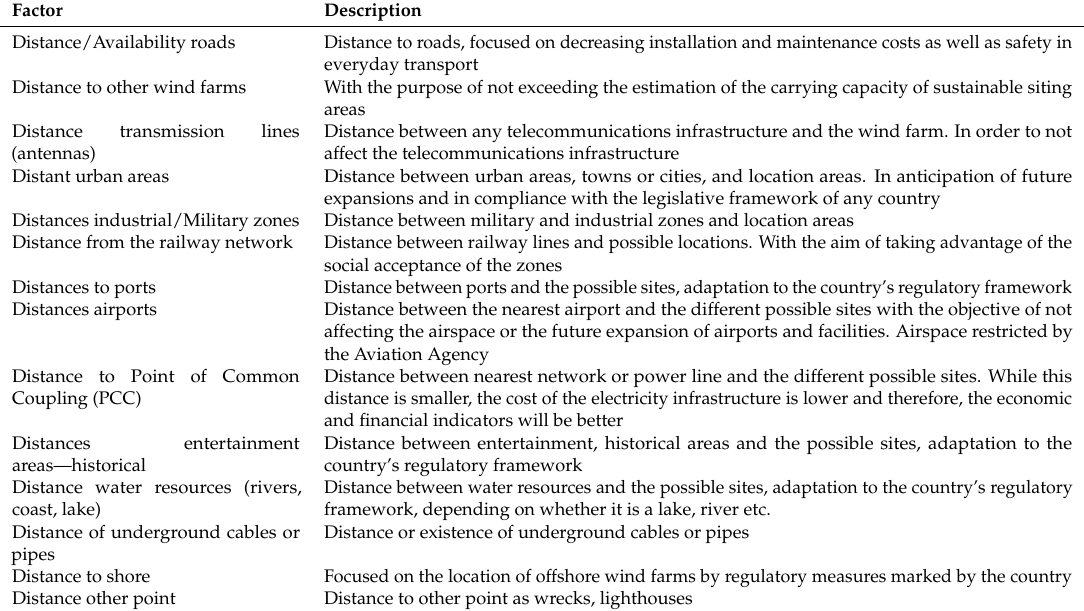
Table 4. Description of factors involved in the optimal location in the wind farms. Location category.